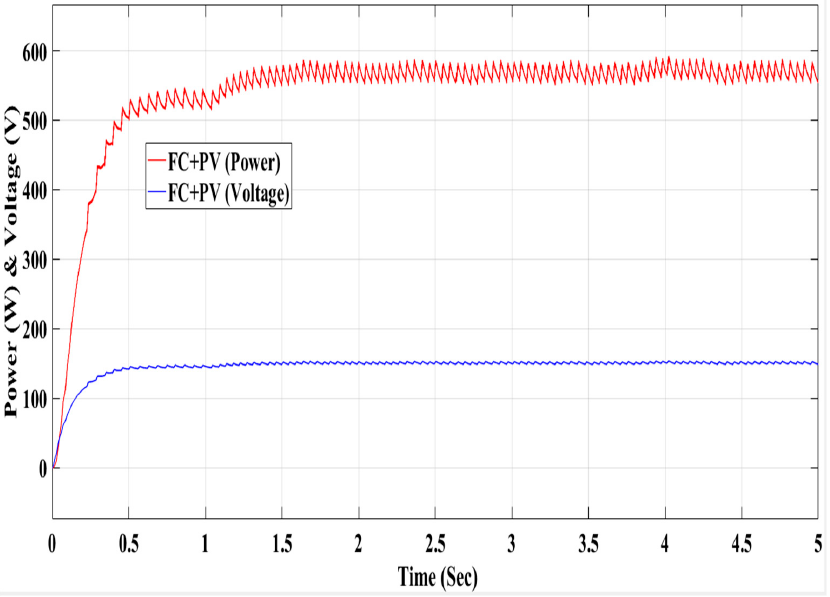
Figure 24. Power and voltage characteristics of the FC–PV model using the P&O based MPPT method.